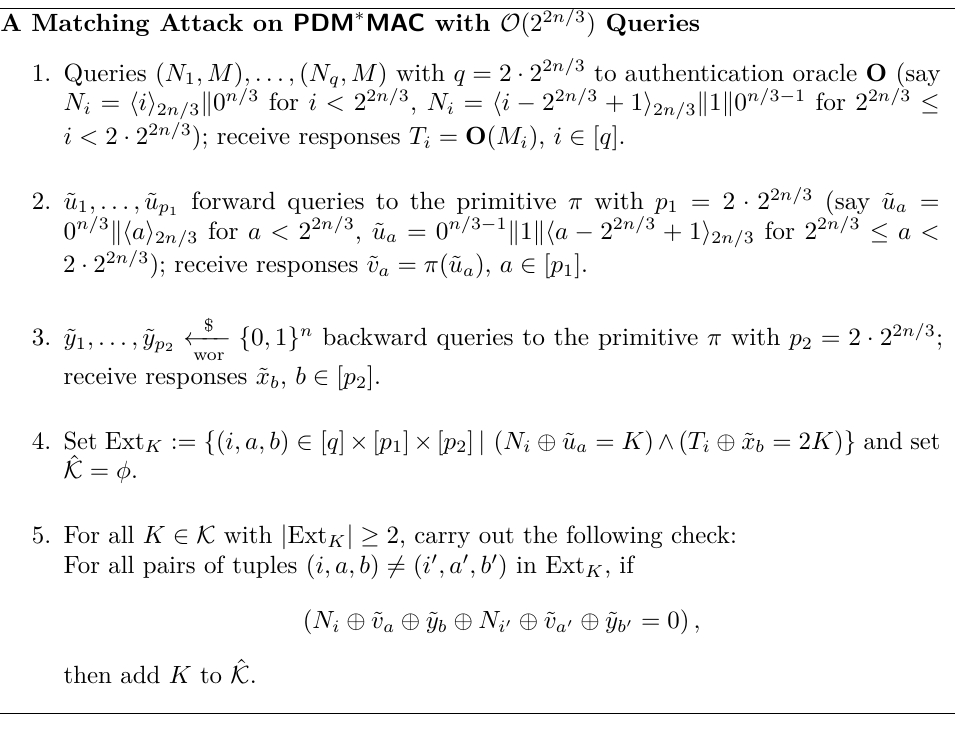
Figure 6: Interaction of the adversary with ( O , π ), where O is either the random oracle or the real construction oracle PDM ∗ MAC π and the primitive π K